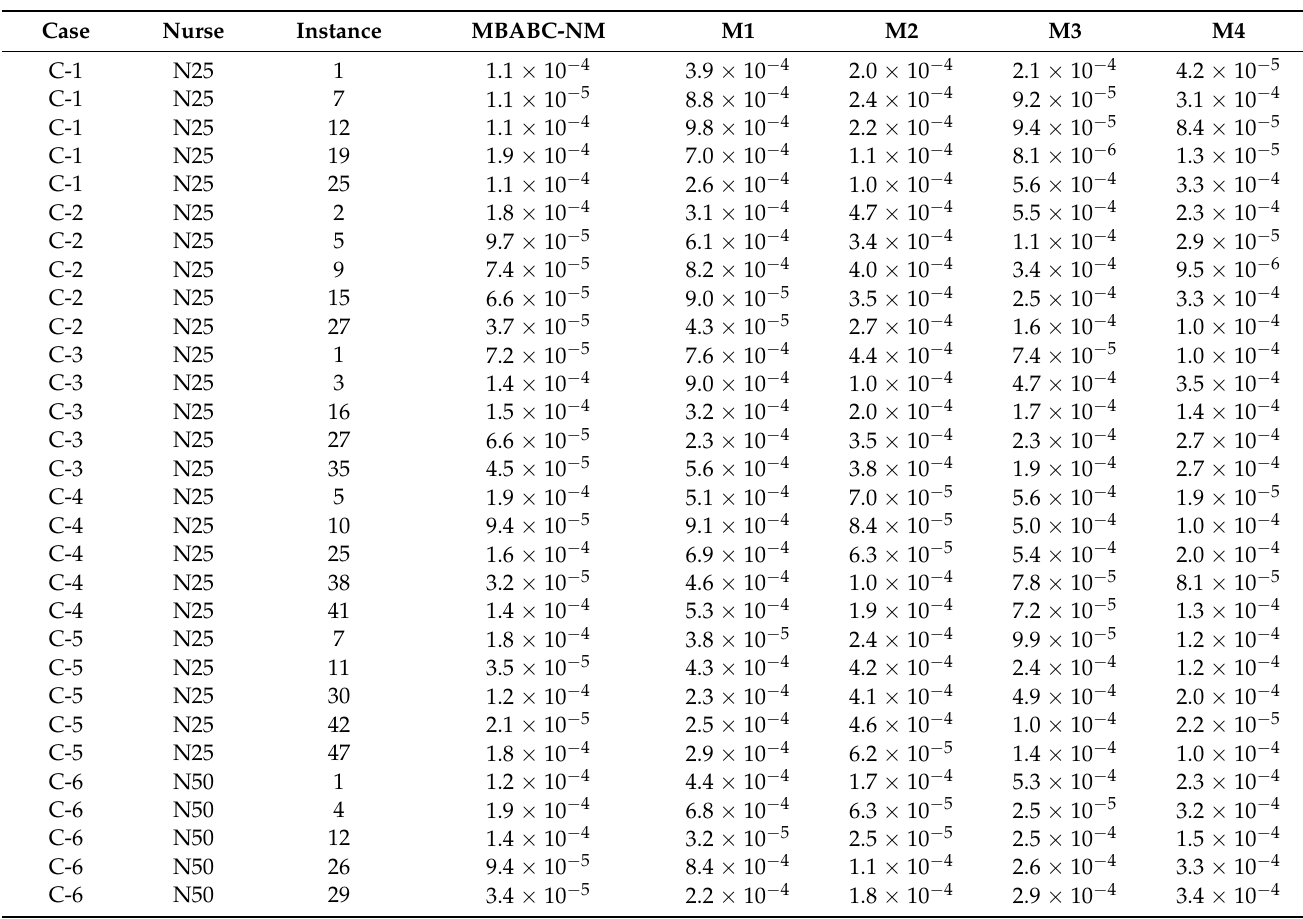
Table 6. Experimental results of NSP dataset in terms of